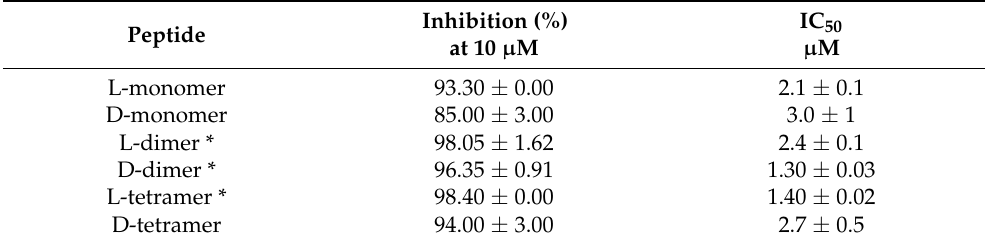
Table 3. PL pro activity by peptide analogs of p-BThTX-I at the concentration of 10 µ M and IC 50 values. Representative concentration–response inhibition curves against PL pro from SARS-CoV-2 are presented in the Supplementary Material (Figure